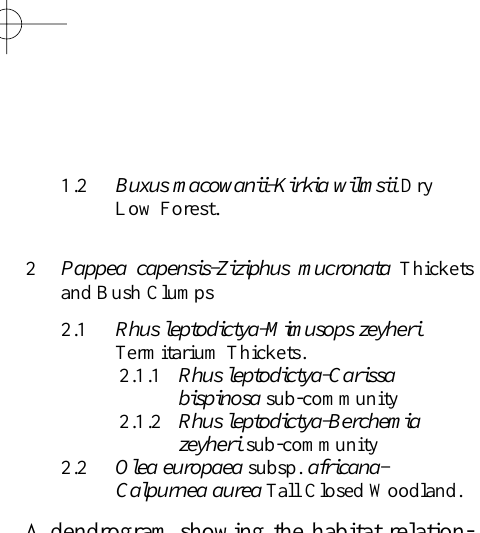
Olea europaea- Diospyros whyteana Major